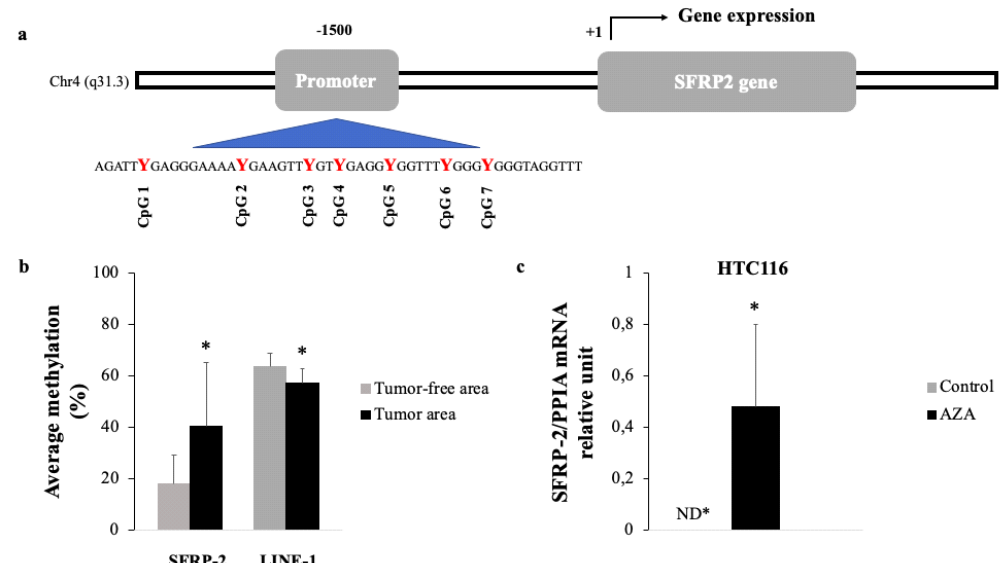
Figure 1. Methylation status of SFRP2 in tumoral tissue of patients with CRC. ( a ) A representative picture of the genomic structure of the human SFRP2 gene on chromosome 4q31 and the CpG island included in this study. Bioinformatic analysis demonstrated seven CpG-rich islands located at the − 1500 position, relating to the transcription start site ( + 1). ( b ) Methylation levels of the SFRP2 and LINE-1 genes in 75 tumor tissue biopsies of CRC and adjacent tumor-free areas were analyzed by bisulfite treatment and pyrosequencing. Comparison through paired t -test ( c ) Quantitative RT-PCR was used to determine the expression of SFRP2 in HTC116, after treatment with AZA, during 72 hours. The mRNA expression of SFRP2 was normalized to the PPIA expression. The results are displayed as mRNA relative mean expression ± SD. Abbreviations: SFRP2 — secreted frizzled-related protein type 2; LINE-1 — long interspersed element type 1; PPIA — peptidylprolyl Isomerase A;